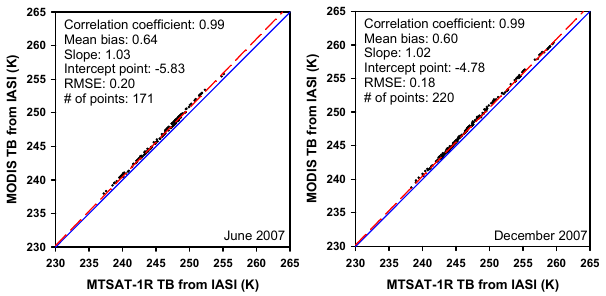
Fig. 2. Brightness temperatures inferred from IASI measurements Figure 2: Brightness temperatures inferred from IASI measurements for the MODIS and MTSAT-1R 6.8 µ m water vapor channels in June 2007 (left) and December 2007 (right). for the MODIS and MTSAT-1R 6.8µm water vapor channels in June 2007 (left) and December 2007